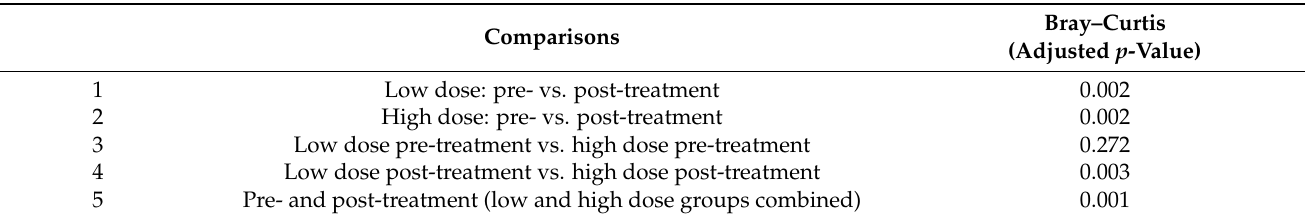
Table 3. Comparisons of Bray–Curtis dissimilarity index between pre- and post-treatment samples in the treatment groups.